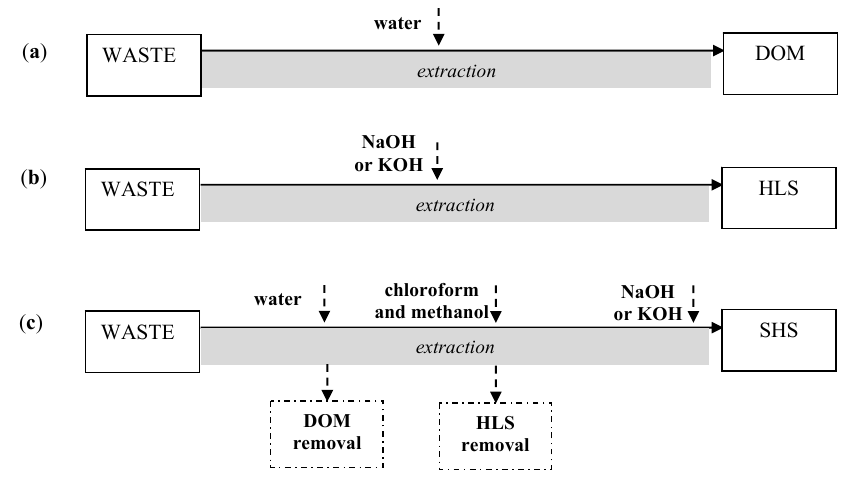
Figure 3. Isolation of washing agents (WAs) from wastes: ( a ) dissolved organic matter (DOM); ( b ) humic-like substances (HLS); ( c ) soluble humic substances (SHS).